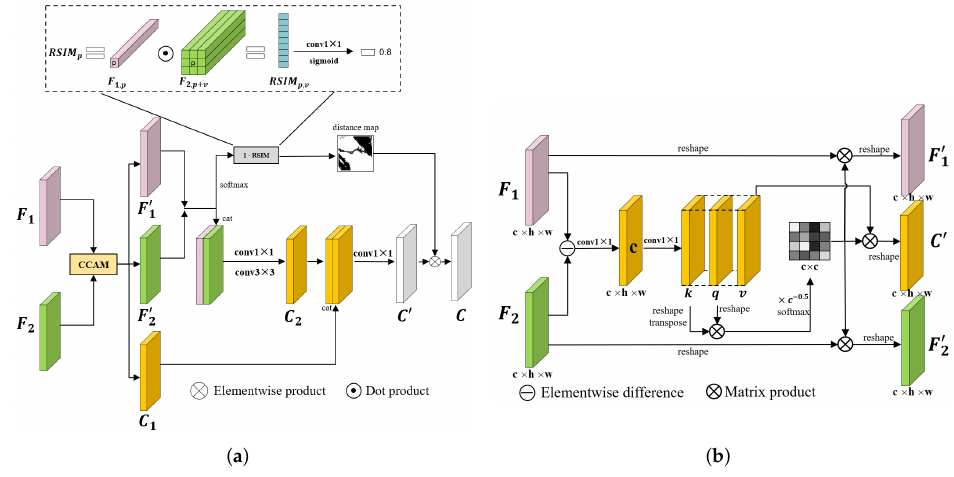
Figure 5. The details of the RFFM. ( a ) The overall architecture of the RFFM, where F 1 and F 2 denote bitemporal features and C indicates change feature. All the convolution layers in the figure are followed by BN and ReLU. ( b ) The illustration of the CCAM, where h , w , and c are the height, width, and channel of the feature maps, respectively. The symbols k , q , and v indicate the key matrix, query matrix, and value matrix. Only the first convolution in this figure is followed by BN and